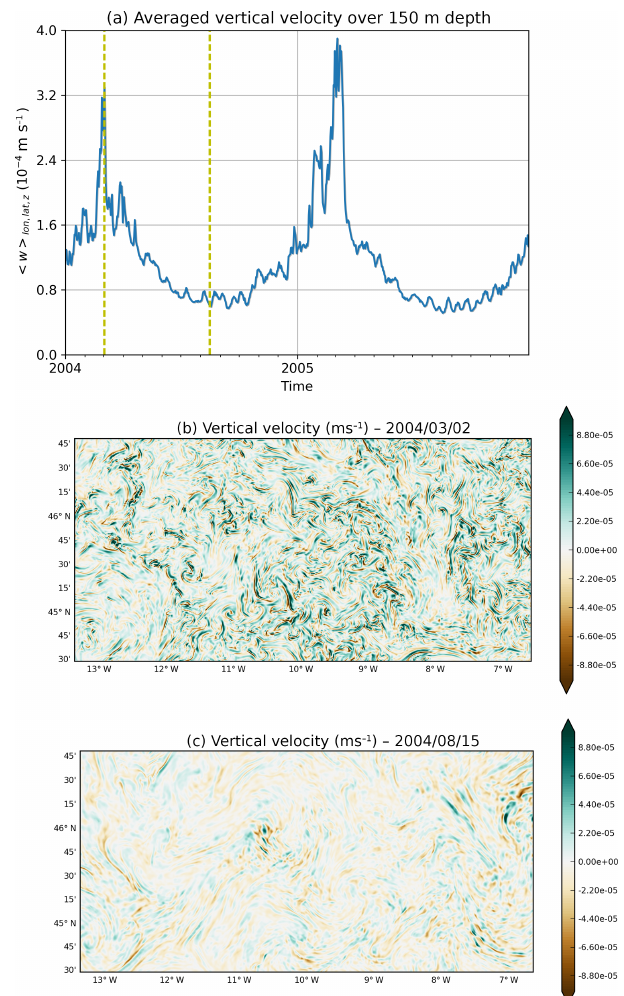
Figure 12. Vertical velocity averaged over 150m depth and spa- tially averaged for the years 2004 and 2005 (a) . Map of the vertical velocity at 4m depth for 2 March 2004 (b) and 15 August 2004 (c) .